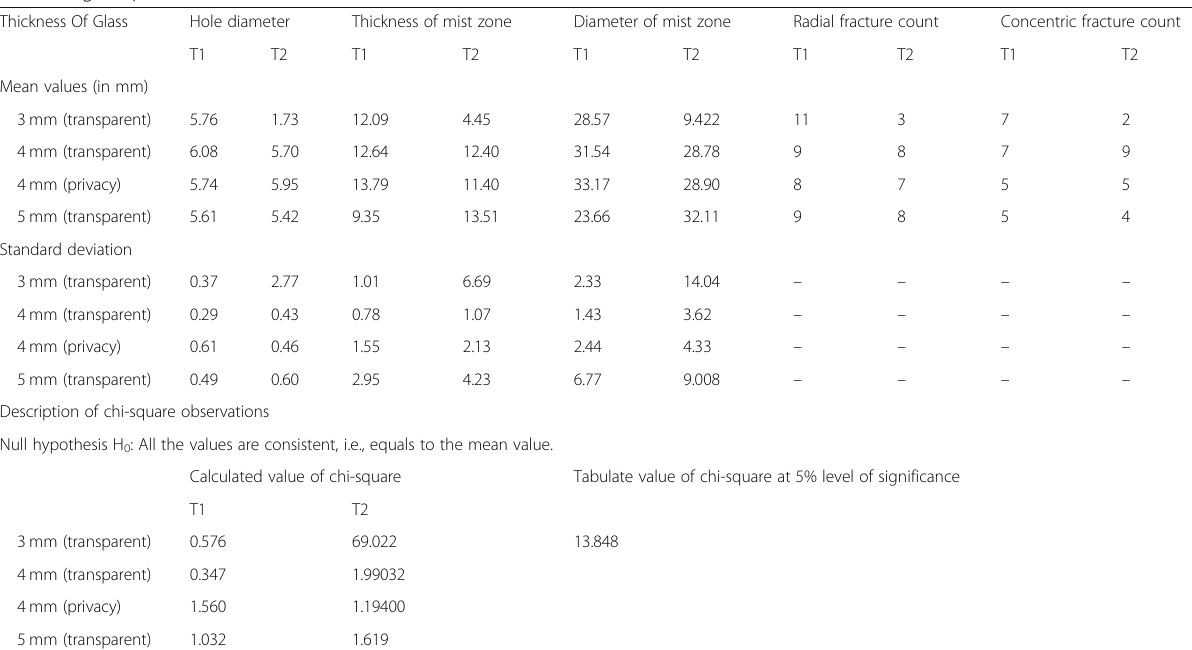
Table 2 Value of mean and standard deviation of the measurements and description of the chi-square test for the T1 and T2 of different glass panes Thickness Of Glass Hole diameter